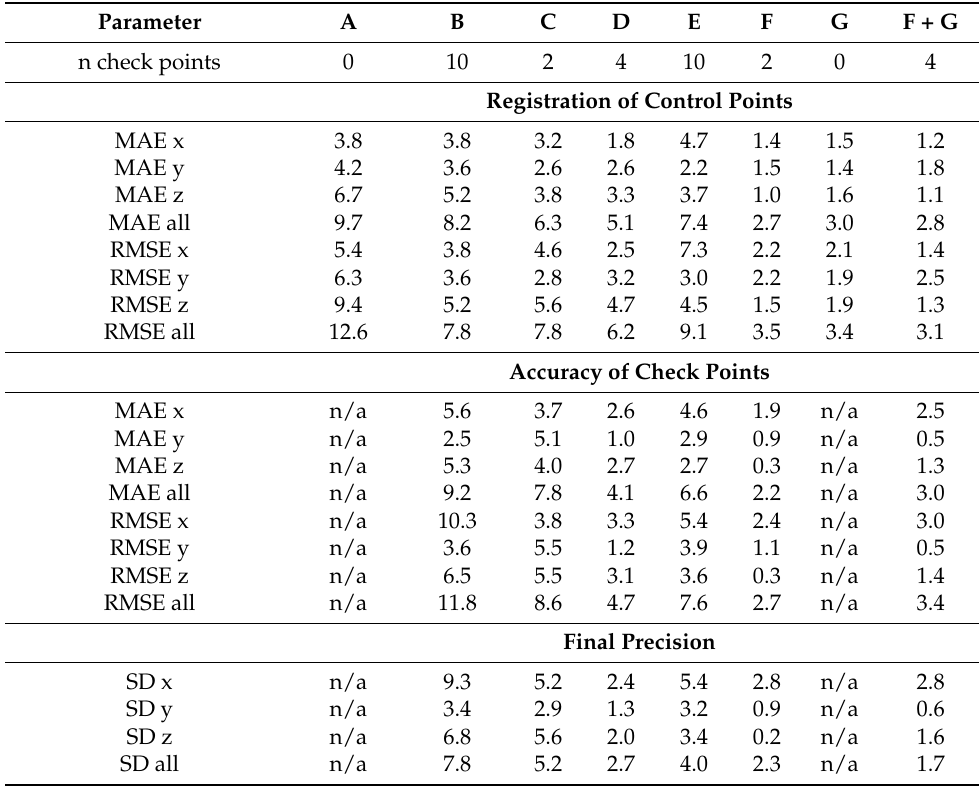
Table 3. Data quality (cm) of the processed SfM-UAV topographies (see Table 1).